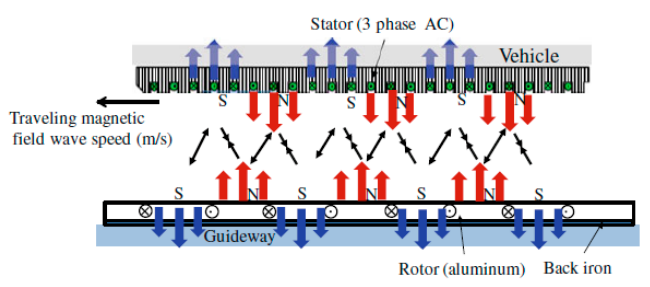
Figure 1. Electromagnetic forces in a linear induction motor (LIM).